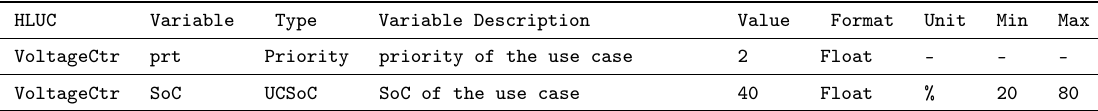
Table 6. Parameters of a HLUC (e.g., VoltageCtr).